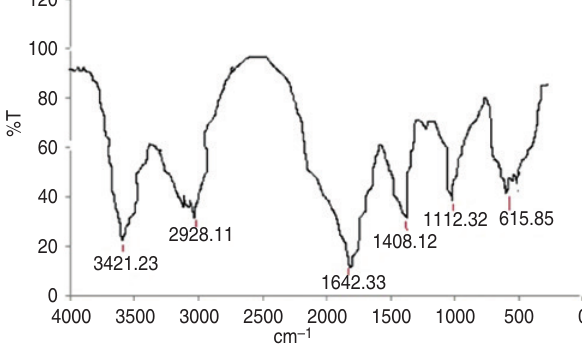
Figure 8: Fourier transform infrared spectroscopy diffraction pattern of the synthesis of gold nanoparticles.